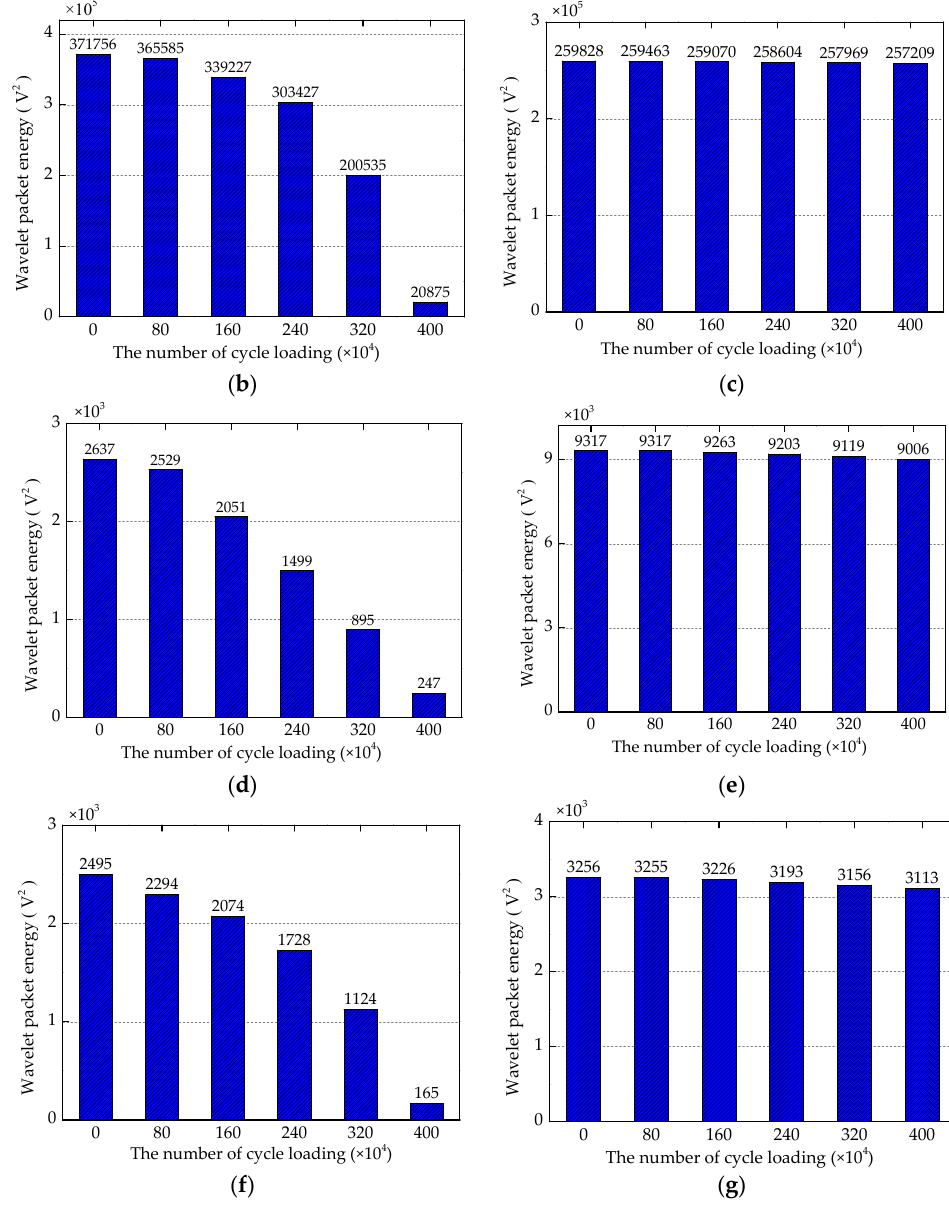
Figure 13. Wavelet packet energy analysis results of the specimen during the fatigue test. ( a ) The south side of CB/SB1 joint. ( b ) The south side of CB/SB2 joint. ( c ) The north side of CB/SB2 joint. ( d ) The south side of CB/SB3 joint. ( e ) The north side of CB/SB3 joint. ( f ) The south side of CB/SB4 joint. ( g ) The north side of CB/SB4 joint.